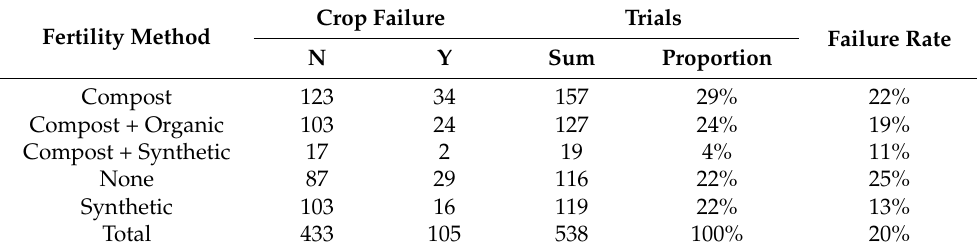
Table 6. Crop failure rate (N = no, Y = yes) by fertility regime as self-reported by trial participants in 2019 and 2020. Categorical analysis of crop failure by site was not significant at an alpha level of 0.1 ( p =